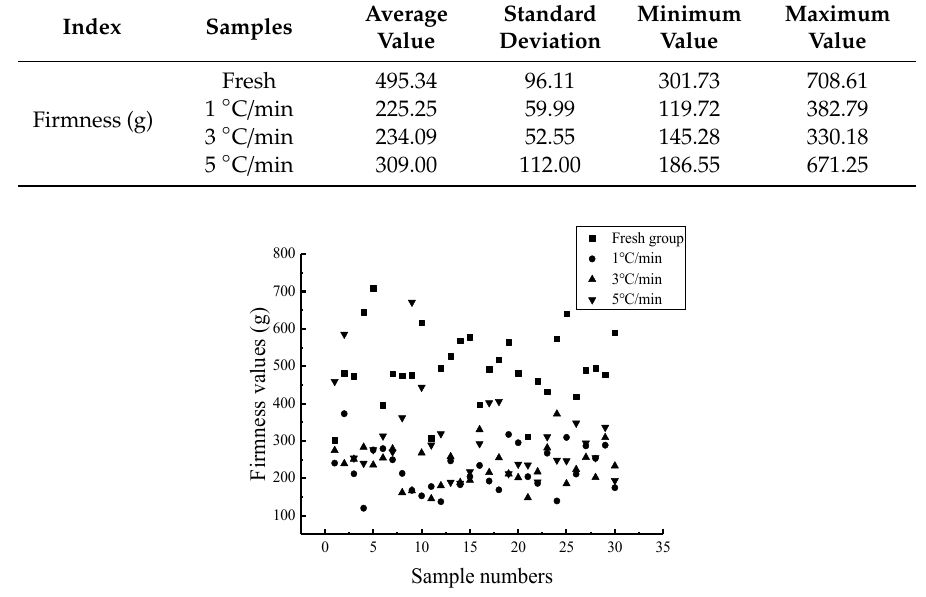
Table 8. Firmness values of the Nanguo pears.